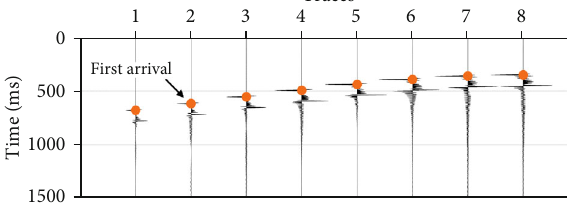
Figure 7: Forward modeling simulated signal pro fi